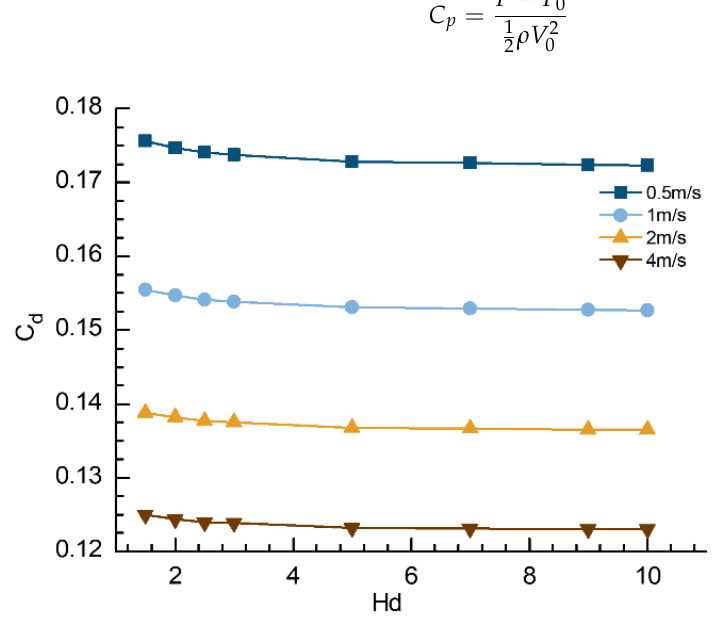
Figure 6. Bare UUV resistance characteristics.